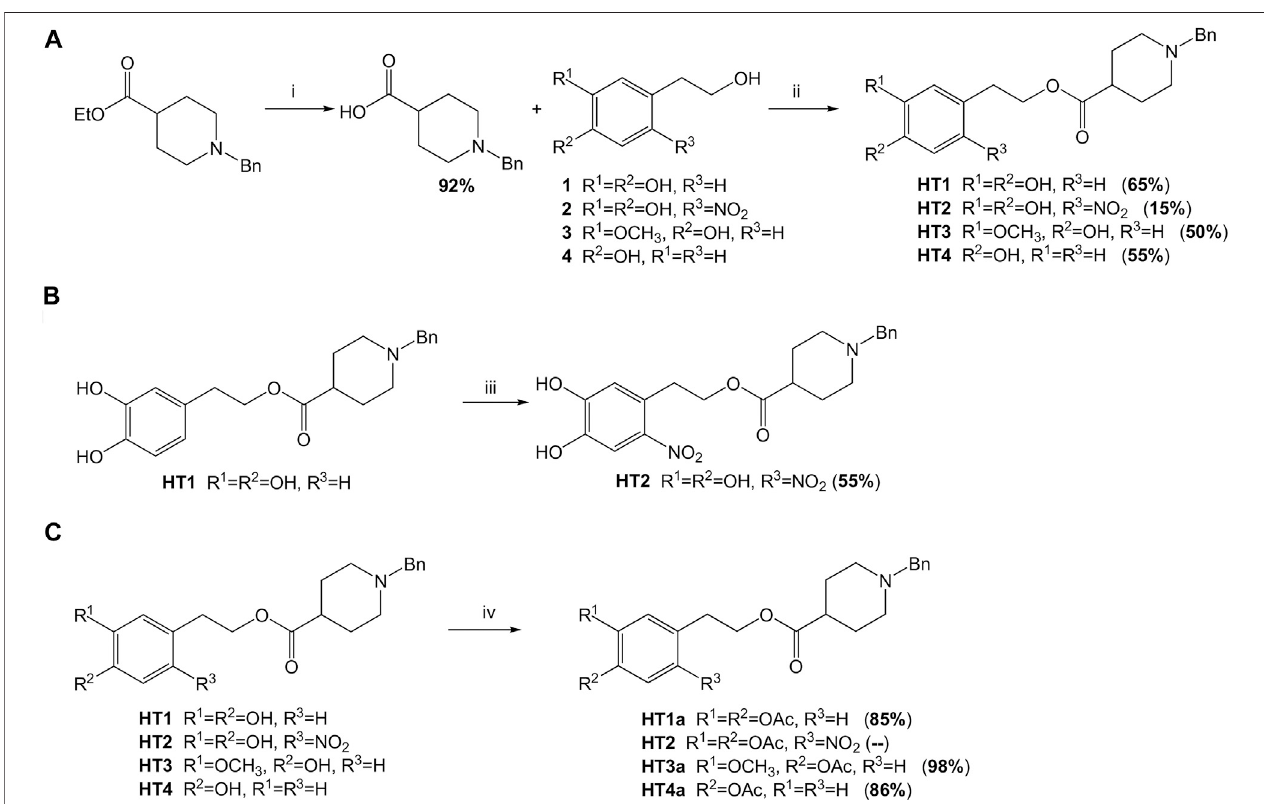
FIGURE 2 | Schematic synthesis of the donepezil hybrids. (A) Reagents and conditions: i) 1) NaOH (0.2 N), CH 2 Cl 2 -MeOH (9:1), 48 h; 2) HCl (pH (cid:1) 2 – 3); ii) CTMS, THF, 40 ° C, 6 days. (B) Reagents and conditions: iii) NaNO 2 , AcOH/AcONa buffer (pH (cid:1) 3.75), rt, dark, 30 min (C) Reagents and conditions: iv) Ac 2 O dry, 4 Å MS, MW, 100 ° C, 25